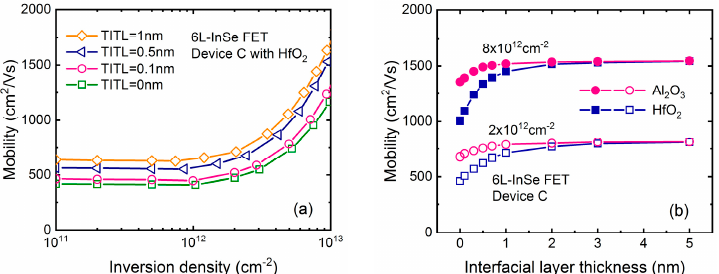
Figure 7. ( a ) Mobility as a function of inversion density featuring different SiO 2 interfacial layer thickness in InSe FET with dual-gate structure of Figure 1c. ( b ) Mobility as a function of SiO 2 interfacial layer thickness at different inversion density in both Al 2 O 3 - and HfO 2 -gated InSe FET. EOT = 1 nm of high- κ dielectric is used in the simulation.